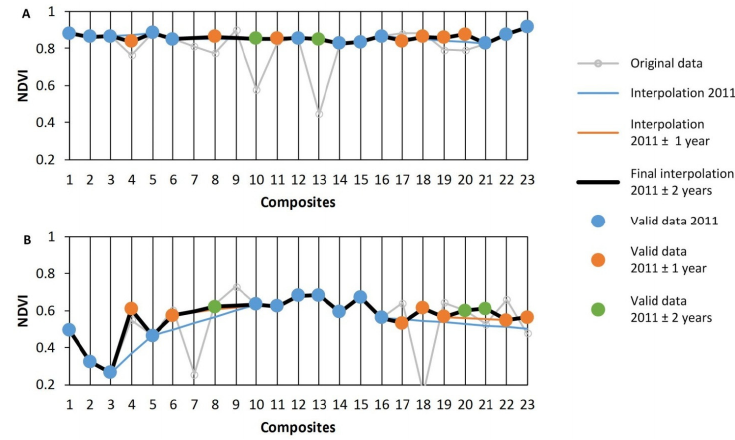
Figure 4. Time series with multi-year data integration using valid observations and interpolation. Large filled circles indicate data used for the time series, void circles show omitted data. ( A ) Evergreen broadleaf forest (2.95086° N, 69.80172° W); and ( B ) savanna (3.49735° N, 72.29125° W).